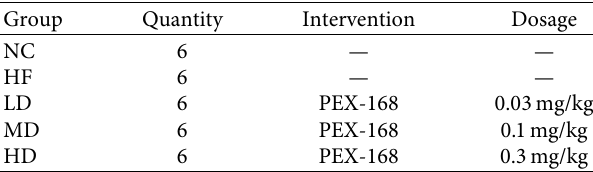
Table 1: Group of experiments.